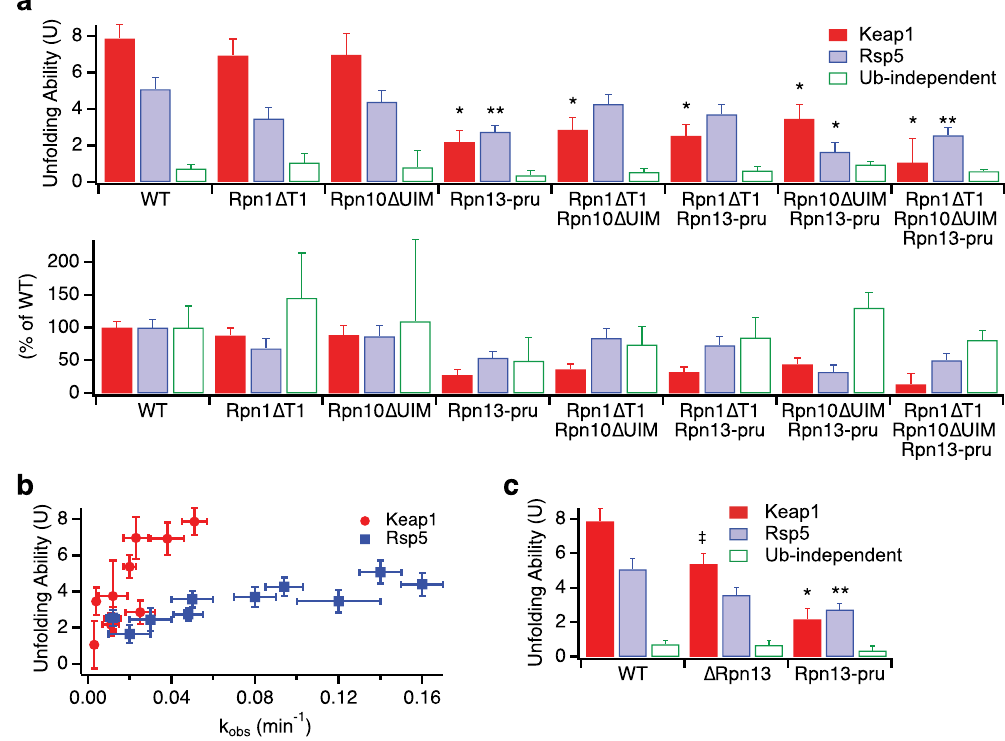
Figure 4. Ubiquitin receptor mutants have varied effects on proteasomal unfolding ability. ( a ) Top: Effect of point mutants in ubiquitin binding domains on proteasomal unfolding ability, as measured using Keap1 (red) or Rsp5 (blue) ubiquitinated substrates or a ubiquitin-independent substrate (green). Error bars are the SEM propagated from curve fitting 4–22 collected data sets. Bottom: unfolding abilities of mutants as normalized to wild-type proteasome. ( b ) Unfolding ability (From panel A above) versus observed rate constant for disappearance of full-length protein ( k obs ) for Keap1 (red circles) and Rsp5 (blue squares) ubiquitinated substrates (from curve fits in Figs 3a and S3). ( c ) Rpn13 deletion ( ∆ Rpn13) has a smaller effect on proteasomal unfolding ability than Rpn13 point mutations that prevent ubiquitin binding (Rpn13-pru). Error bars are the SEM propagated from curve fitting 4–22 collected data sets. For ( a , c) , two-tailed t-tests were used to determine significant differences from wild-type with a Bonferroni corrected α of 0.005. * Indicates p ≤ 1 × 10 − 4 , ** indicates p ≤ 0.0013, ‡ indicates p = 0.01 relative to